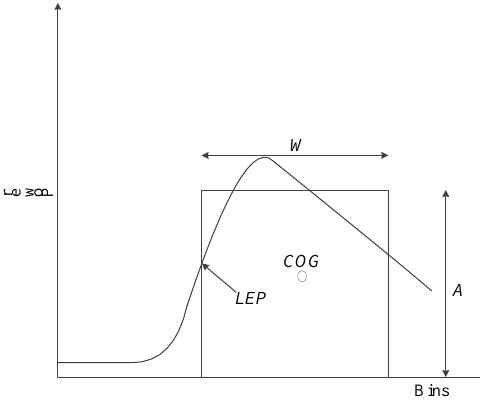
Figure 1. Schematic diagram of the OCOG